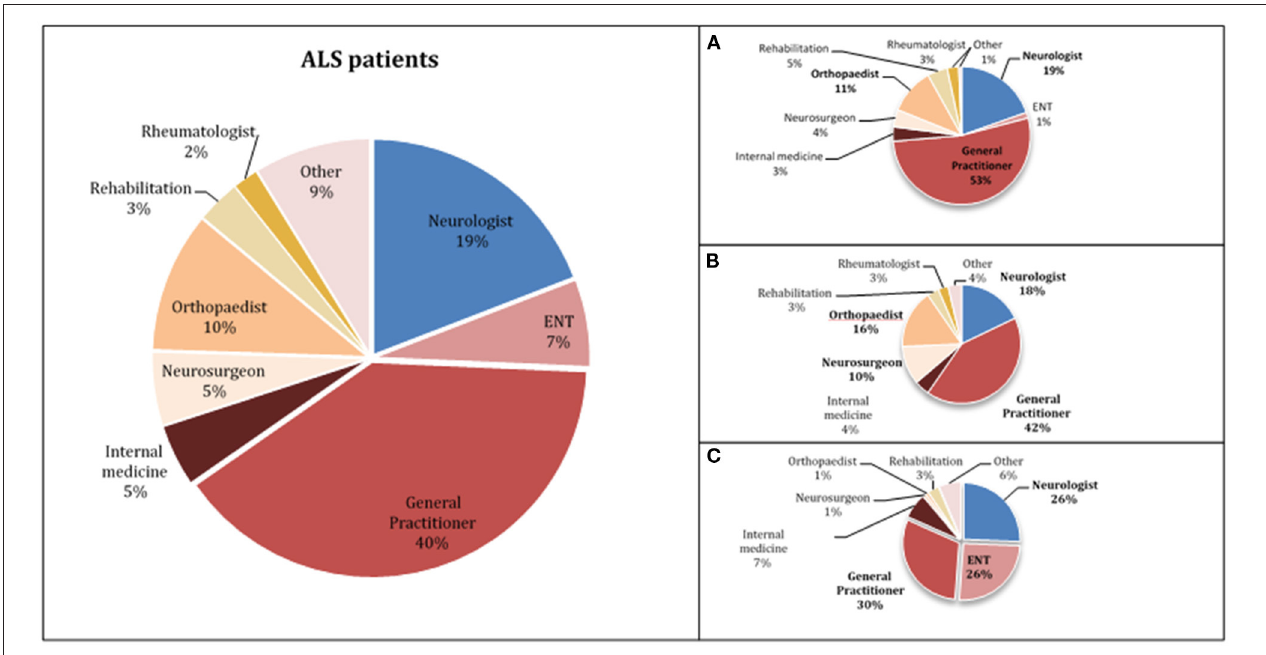
FIGURE 2 | Specialist physicians who first evaluated ALS patients ( A —upper limbs onset, B —lower limbs onset, C —bulbar-onset).